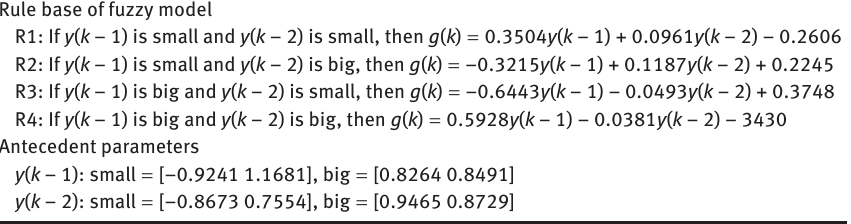
Table 2: The Fuzzy Model Obtained by the NSFOA Algorithm. Rule base of fuzzy model